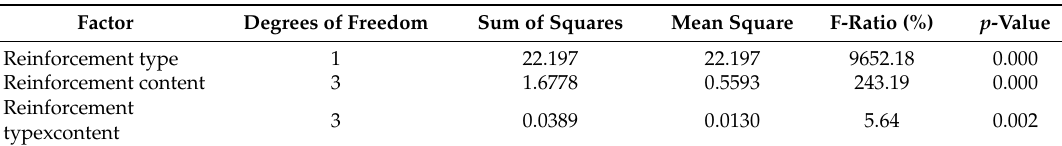
Table 6. Two-way ANOVA of shrinkage in the flow direction.